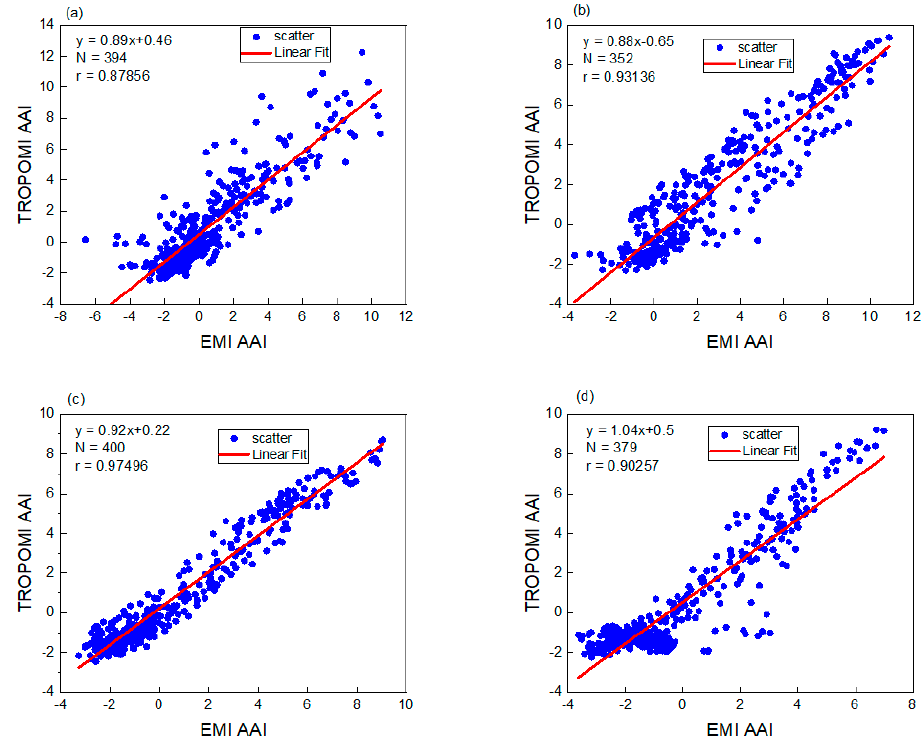
Figure 13. Comparisons of EMI and TROPOMI AAI observations on 9 ( a ), 10 ( b ), 11 ( c ), and 12 ( d ) November 2019.